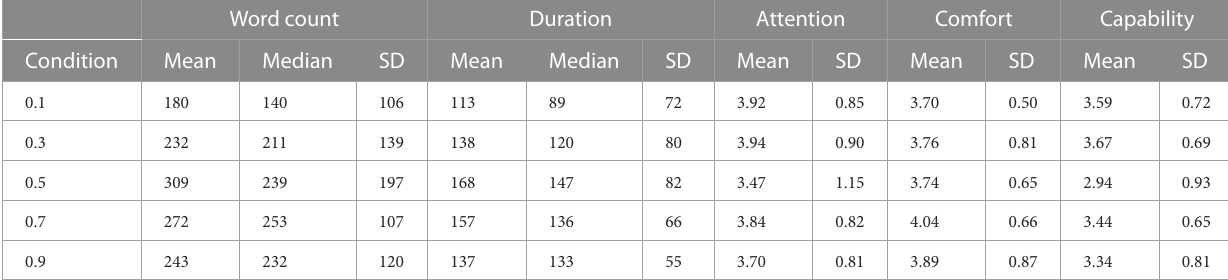
TABLE5 Descriptivestatisticsofthewordcountandinteractionduration,aswellastheLikertscale comfort